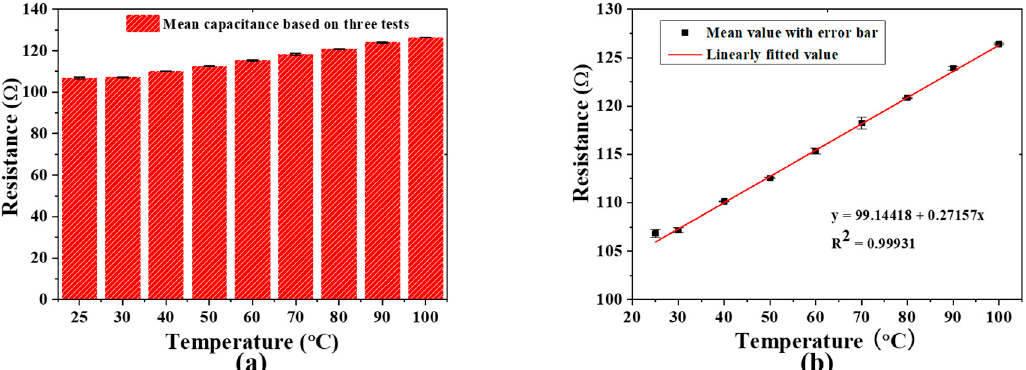
Figure 4. ( a ) The average value of the resistor biosensor response to the glucose solution at different temperatures; ( b ) regression analysis of resistance (n = 9) at different temperatures.